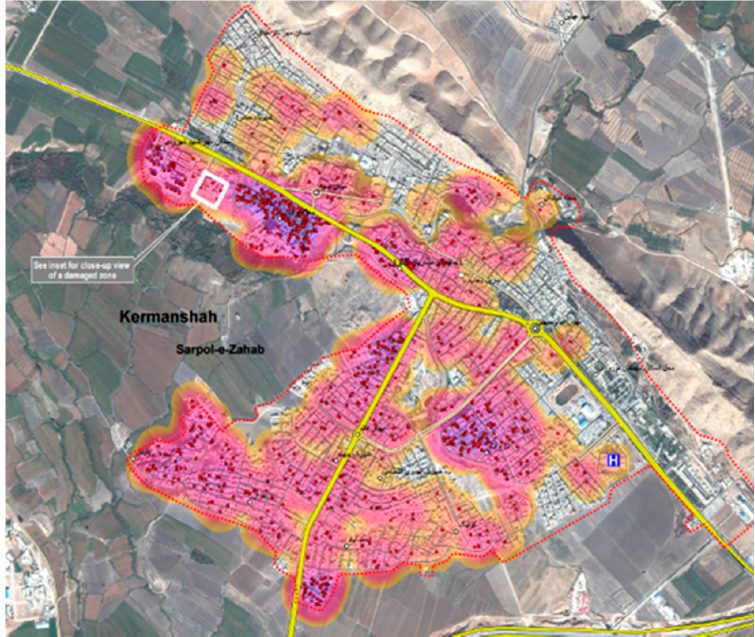
Figure 12. Damage map for Sarpol Zahab. Source: (UNITR) [45].